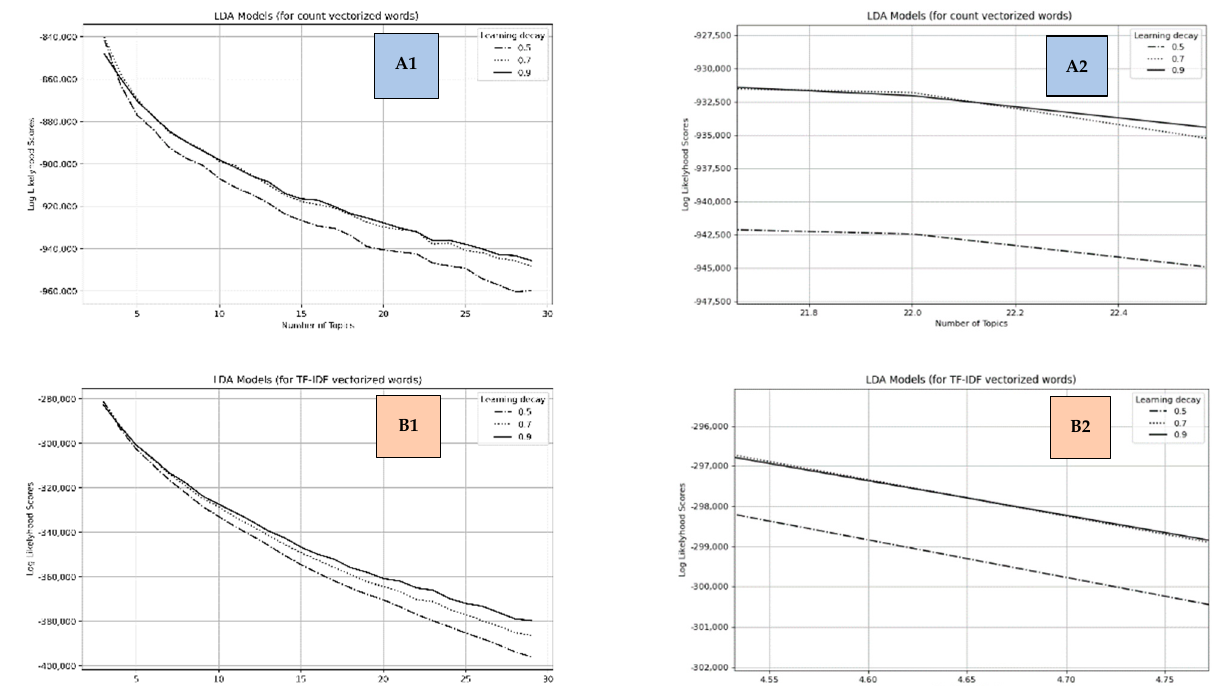
Figure 4. Learning decay curves for both words’ vectors: graphs ( A1 , B1 ) contain the overall curves for the traditional count (frequency), and the TF-IDF vectorized words, successively; graphs ( A2 , B2 ) present the regions where the last overcome between the curves occurred, supporting defining the best topic model.